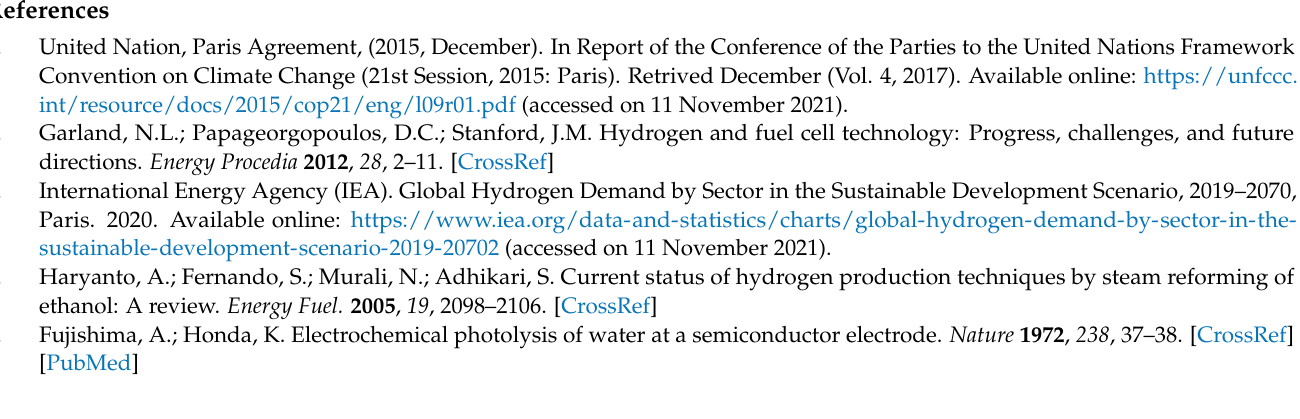
at (a) low resolution and (b) high resolution. Figure S2: EDS spectra of (a) pure PVA and (b) PVA- ZnOS100 composite. Figure S3: Bandgap energy from Tauc plot obtained from UV-vis absorption spectrum of ZnOS. Table S1. Decomposition temperature and weight loss (W.L.) obtained from TGA analysis. Figure S4: H 2 generation as a function of radiation time from ZnS, ZnO/ZnS, and ZnO nanoparticles; (b) average production rate of H 2 of all samples under the UV light irradiation. Figure S5: Hydrogen production rates in µ mol · g − 1 · h − 1 . Figure S6. Radiation spectrum of Xe-Hg lamp used in this experiment. Table S2: Photocatalytic activities for H 2 generation with previous reports (for comparison, production rates were normalized per gram catalyst)